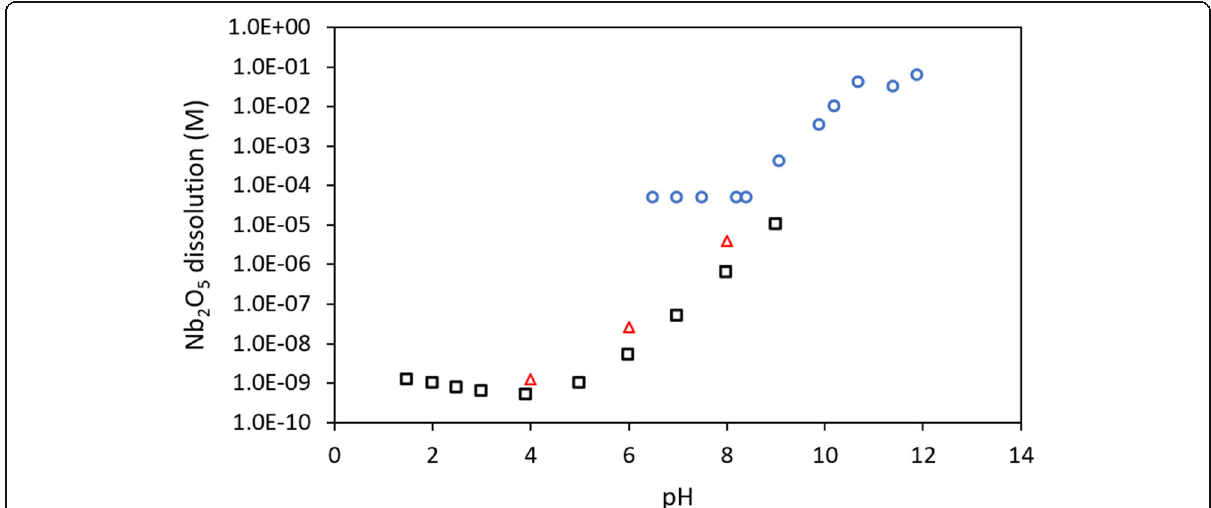
Fig. 4 Nb 2 O 5 dissolution in an aqueous medium versus pH at room temperature. Ref.: Amorphous Nb 2 O 5 [24], H-Nb 2 O 5 [25], Nb 2 O 5 /Al 2 O 3 /Al (present